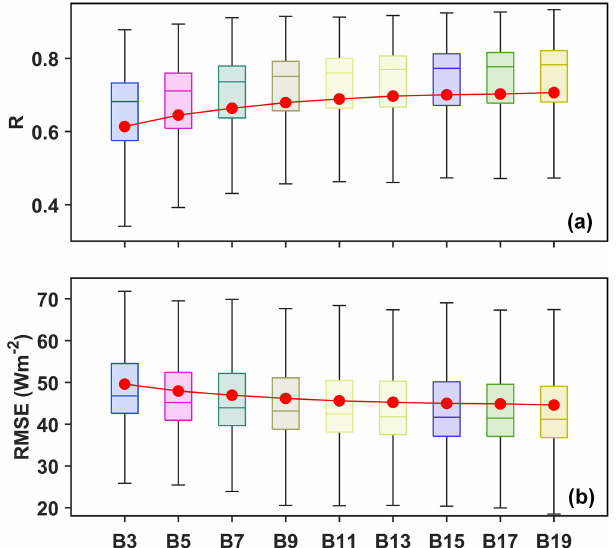
Figure 13. Variations in (a) R and (b) RMSE indices for each spa- tial scale in the MLR model. The red lines in the subplots are the average curves of indices at the different spatial scales.